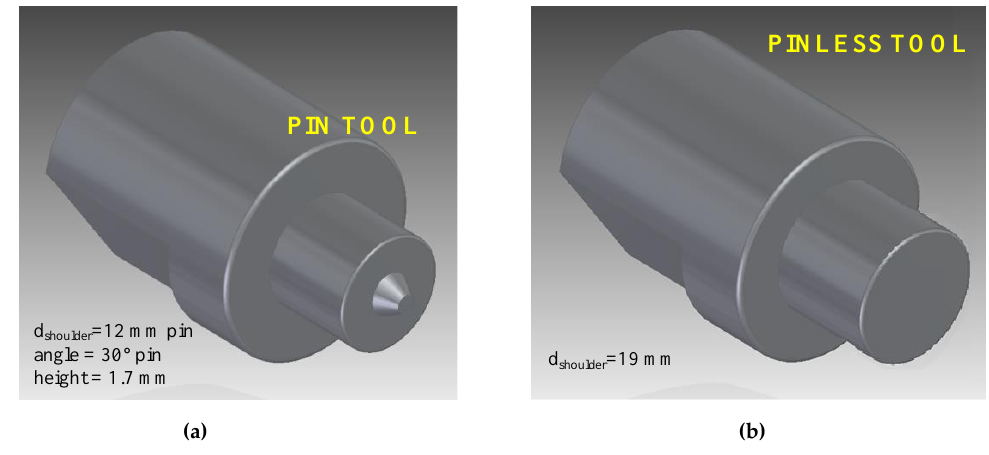
Figure 4. ( a ) Pin and ( b ) pinless tools used for DS-FSW process of 2-mm thick blanks in AA6082-T6 alloy.